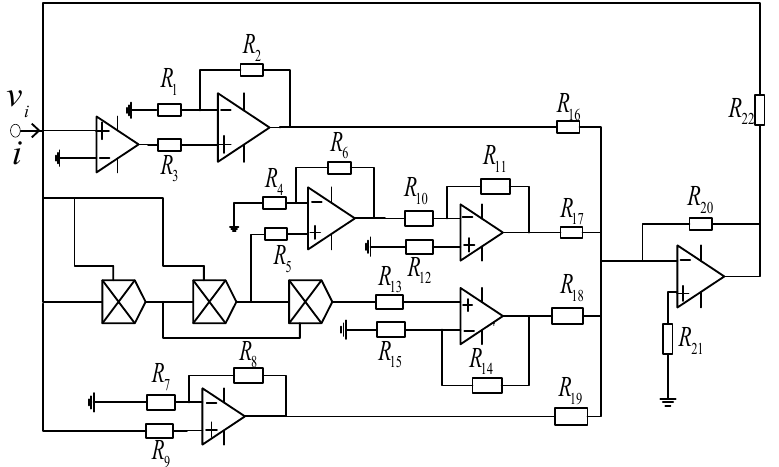
Figure 2. The design of the nonlinear resistor R N in Figure